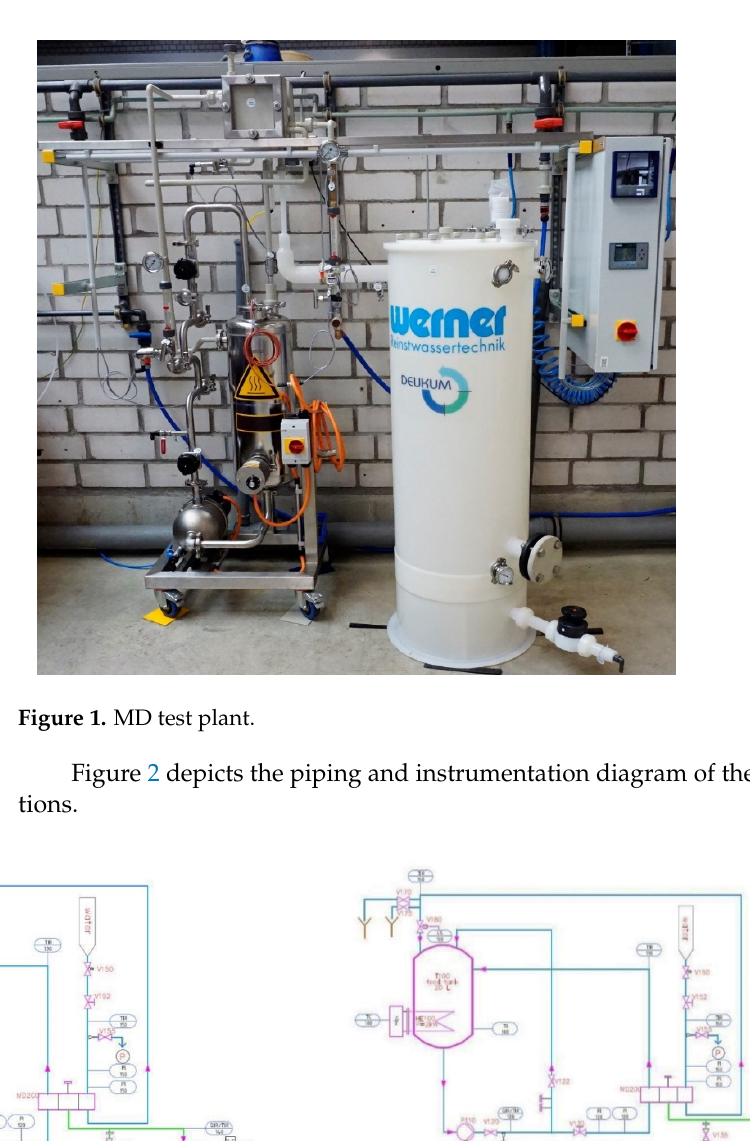
transport. The membrane package used for AGMD consisted of the flat membranes Figure 2. P + I schemes of the test plant. ( a ) AGMD configuration; ( b ) VMD configuration.